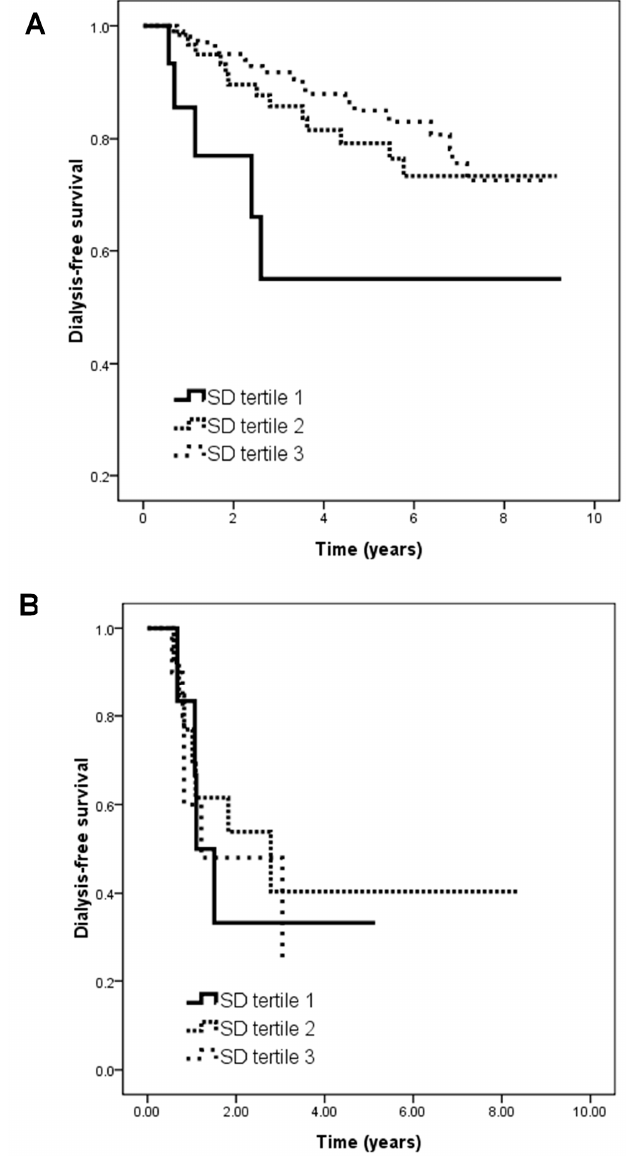
Figure 3. Kaplan–Meier analysis of dialysis-free survival according to tertiles of HbA 1C SD among subjects with ( A ) HbA 1C ≧ 7% and CKD stages 3–4 (log-rank p = 0.045) and ( B ) HbA 1C ≧ 7% and CKD stage 5 (log-rank p = 0.808).